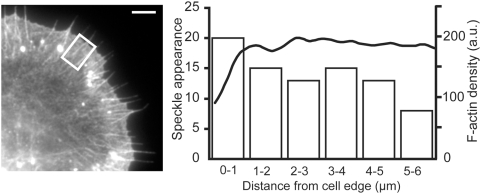
Appearance of AIP1 speckles is roughly proportional to F-actin distribution.Images of EGFP-AIP1 speckles were acquired at intervals of 300 ms for 9 s. Cells were then fixed and stained with TexasRed-phalloidin (left image). The position of newly appeared single-molecule AIP1 speckles were recorded in an area (square) devoid of dense clusters of AIP1 speckles over 25 consecutive images, n = 89. Curve, actin filament distribution measured by phalloidin binding. Columns, the number of newly-emerged AIP1 speckles in each indicated position. A representative result of 3 independent measurements is shown. Bar, 5 µm.